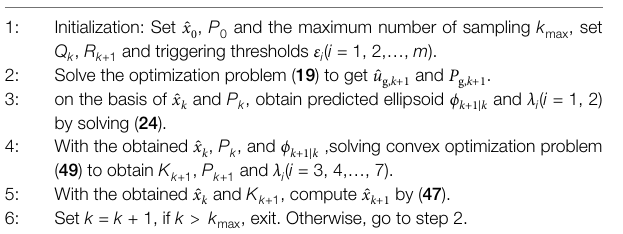
Algorithm 1 | ET-DSMF Algorithm.